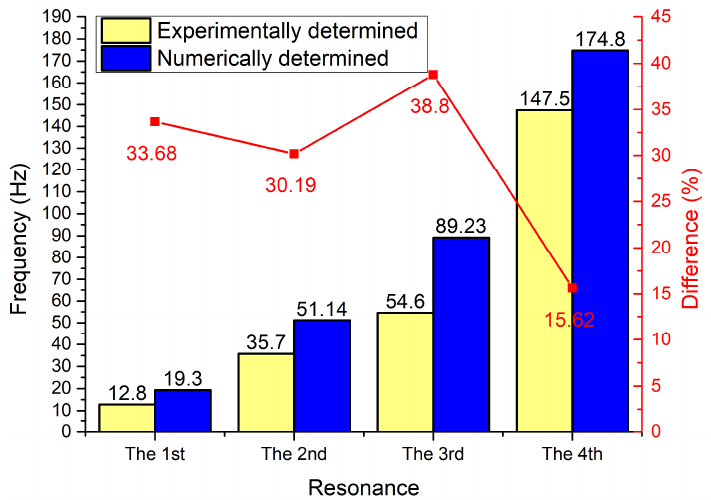
Figure 15. Comparison between calculated and experimentally determined resonance frequencies.